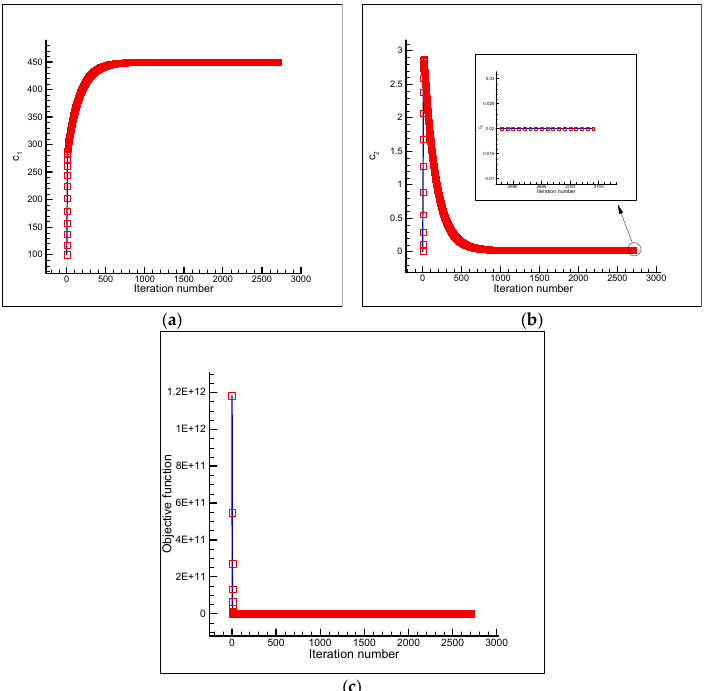
Figure 8. Estimation of 1 c ( a ) and 2 c ( b ), and the objective function versus iteration number ( c ) J 800.0 0.6 ( ) c T = + using the initial guess initial 2 and a single sensor placed at the node  kg. C = ( , ) (3,12) i j .